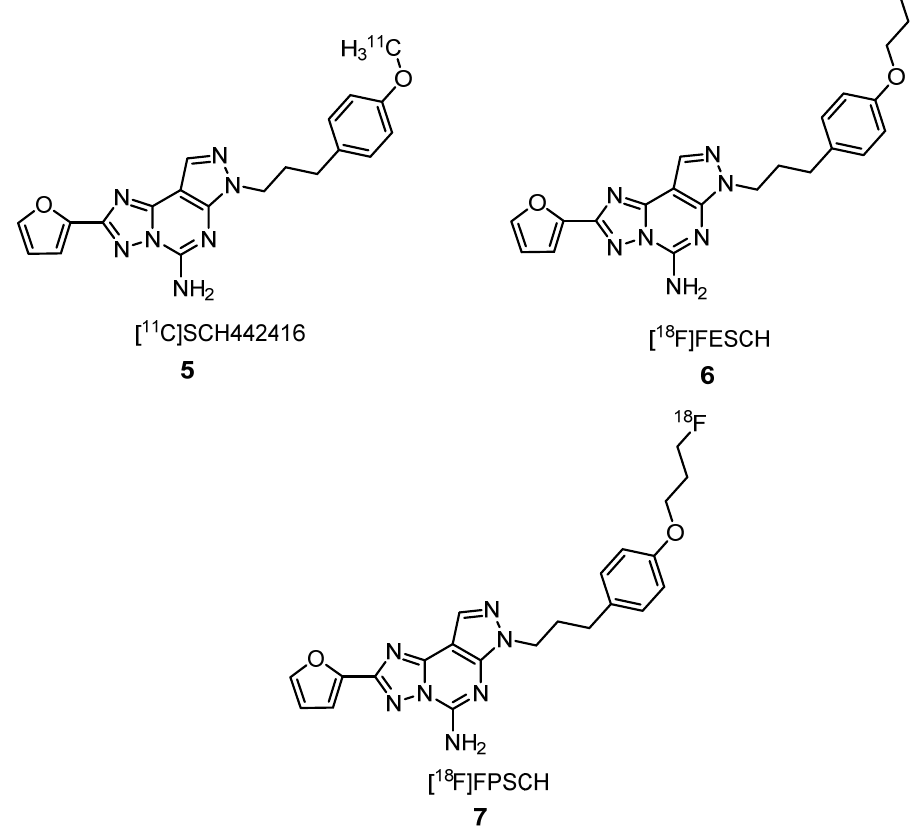
Figure 3. Adenosine receptor (A 2A R) radioantagonists 5 – 7 for PET imaging [32,33].